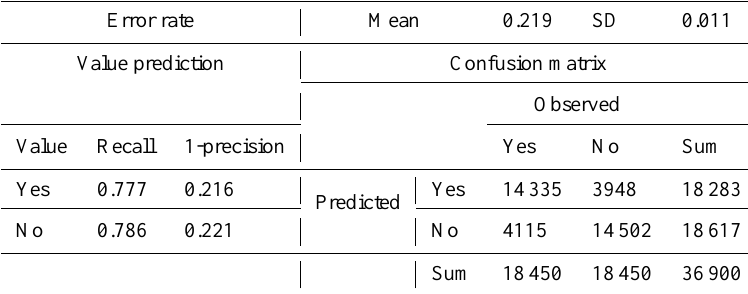
Table 2. Value prediction and confusion matrix of cross-folded validation for the 2009 data